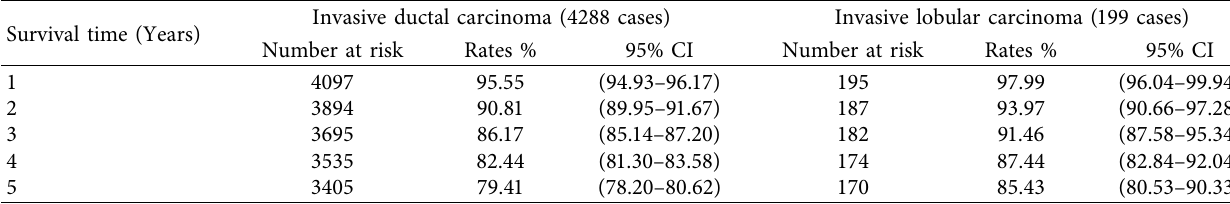
Table 10: Survival rates of two common breast cancer histological types in urban Shenyang from 2008 to 2013. Survival time (Years)